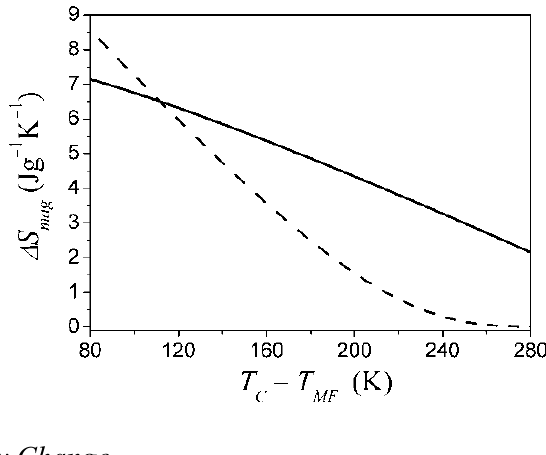
Figure 14. Theoretical values of magnetic entropy change computed using the experimental values of saturation magnetization (solid line) and the solution of Equation